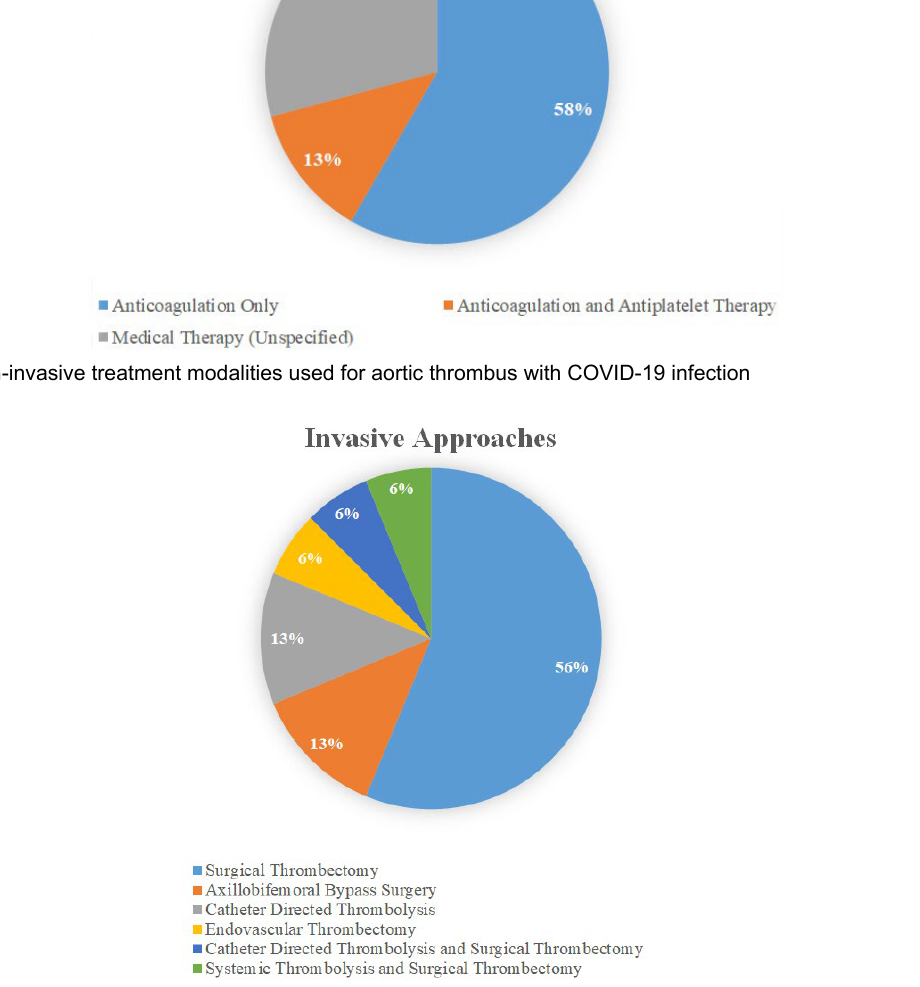
Figure 6. The invasive treatment modalities used for aortic thrombus with COVID-19